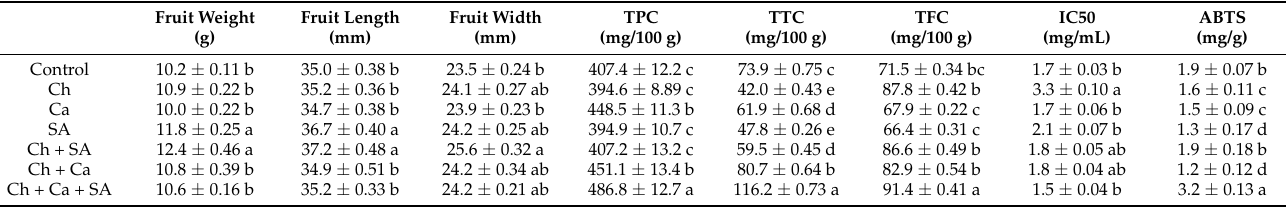
Table 2. Effect of different preharvest treatments on ‘Khesab’ fruit physical characteristics and phytochemical analysis at harvest.